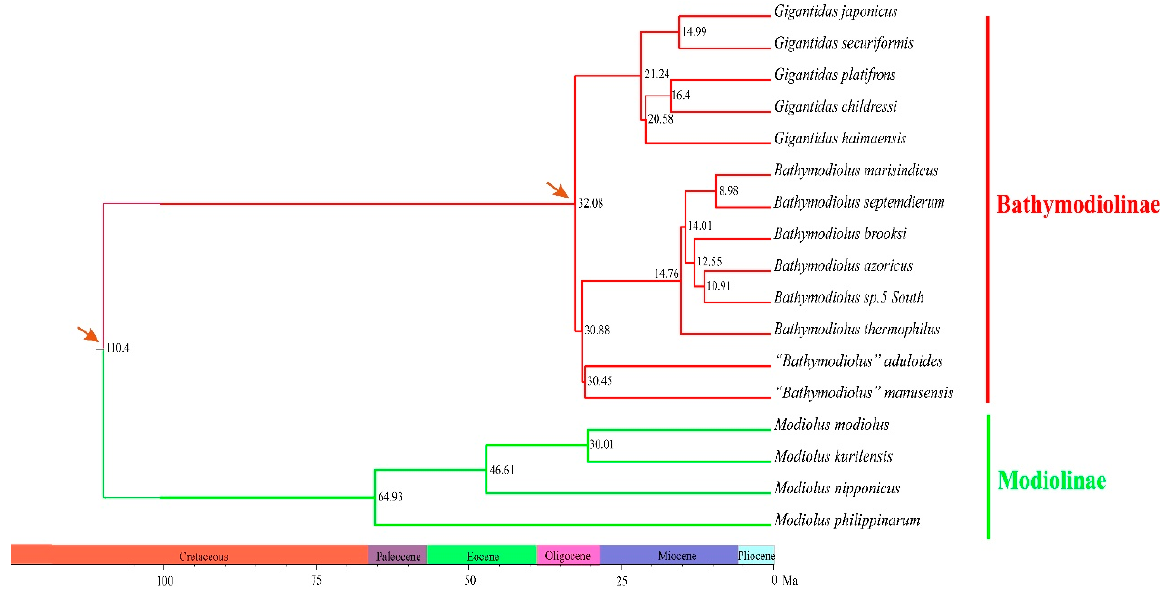
Figure 3. Phylogenetic tree of the deep-sea and shallow-water mussels inferred from 12 protein genes by maximum likelihood. Bayesian posterior probabilities/maximum likelihood (ML) bootstrap support values are shown for each node. An asterisk denotes mtDNA sequence newly determined in this study. Scale bar represents nucleotide substitutions per site.